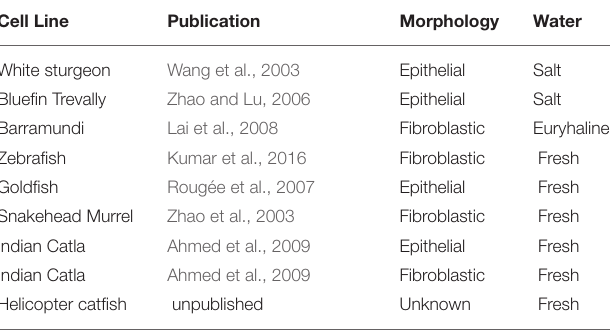
TABLE 1 | Immortalized fish muscle-isolated cell lines available from Cellosaurus. Cell